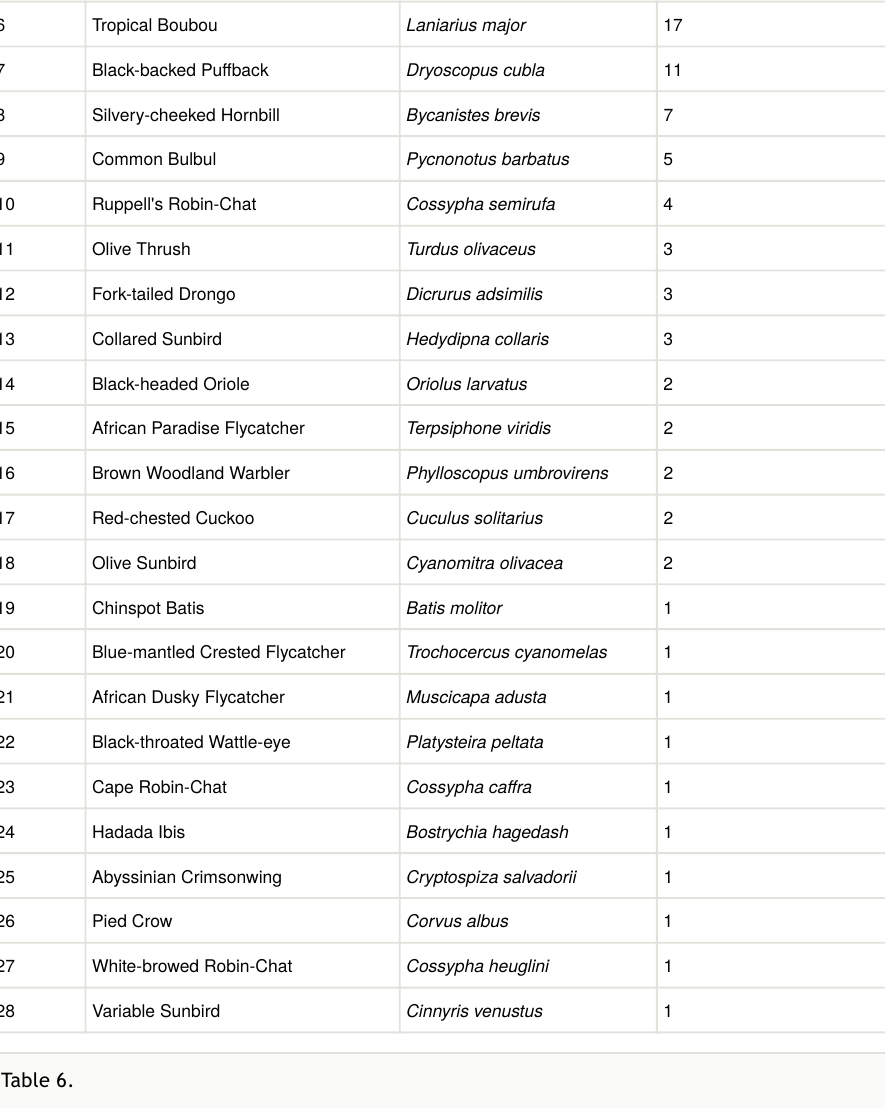
Number of background recordings per